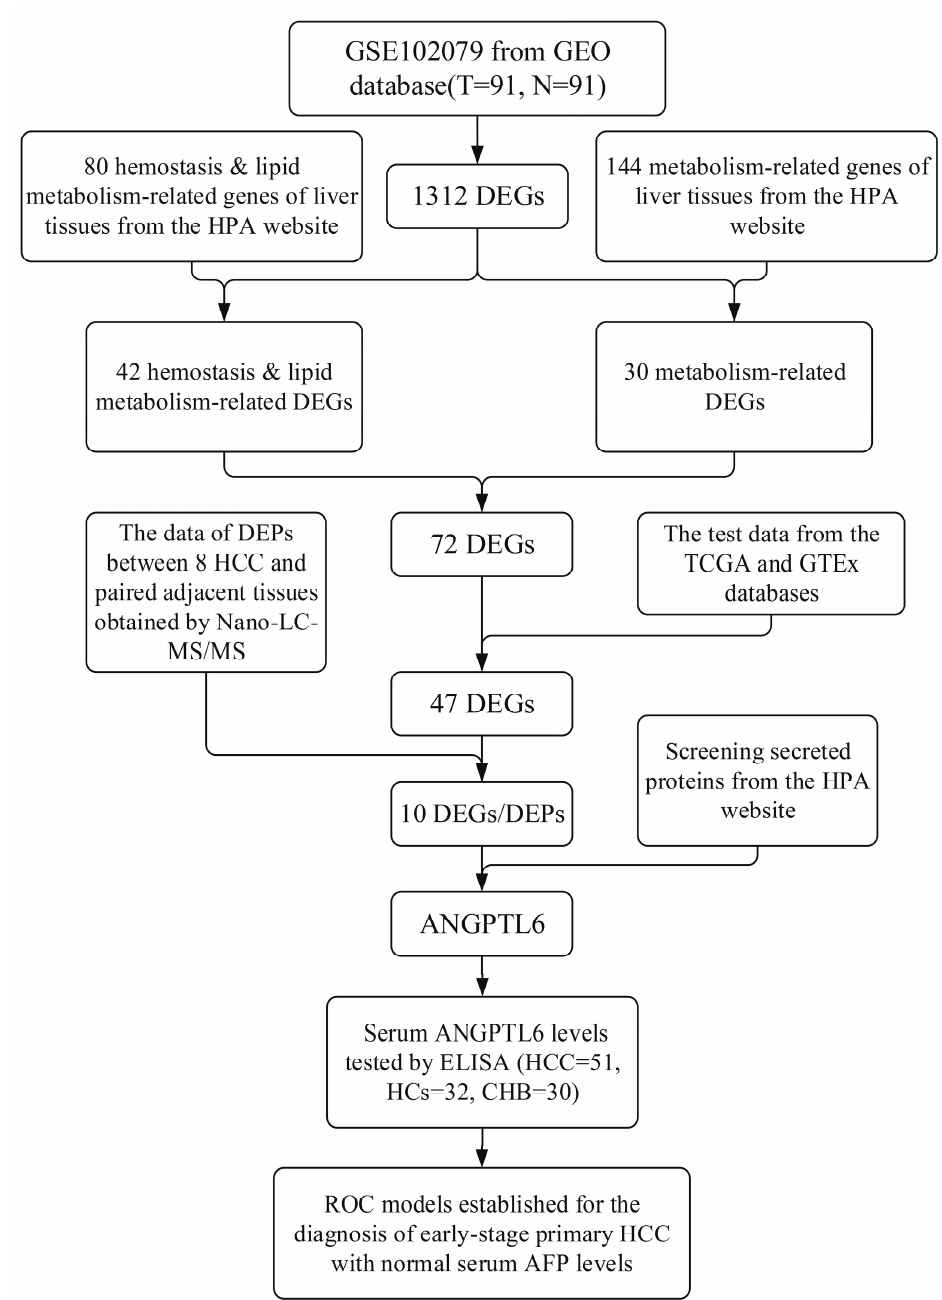
Figure 1. Flow chart of this study. Abbreviations: GEO, Gene Expression Omnibus; T, tumorous tissues of HCC patients; N, adjacent nontumorous tissues of HCC patients; DEGs, differentially expressed genes; HPA, Human Protein Atlas; DEPs, differential expression proteins; Nanoscale Liquid Chromatography–Tandem Mass Spectrometry, Nano-LC ‒ MS/MS; TCGA, The Cancer Genome Atlas; GTEx, Genotype-Tissue Expression; ANGPTL6, angiopoietin-like protein 6; AFP, alpha-fetoprotein; ELISA, enzyme-linked immunosorbent assay; HCC, hepatocellular carcinoma; HCs, healthy controls; CHB, chronic hepatitis B; ROC; receiver operating characteristic.